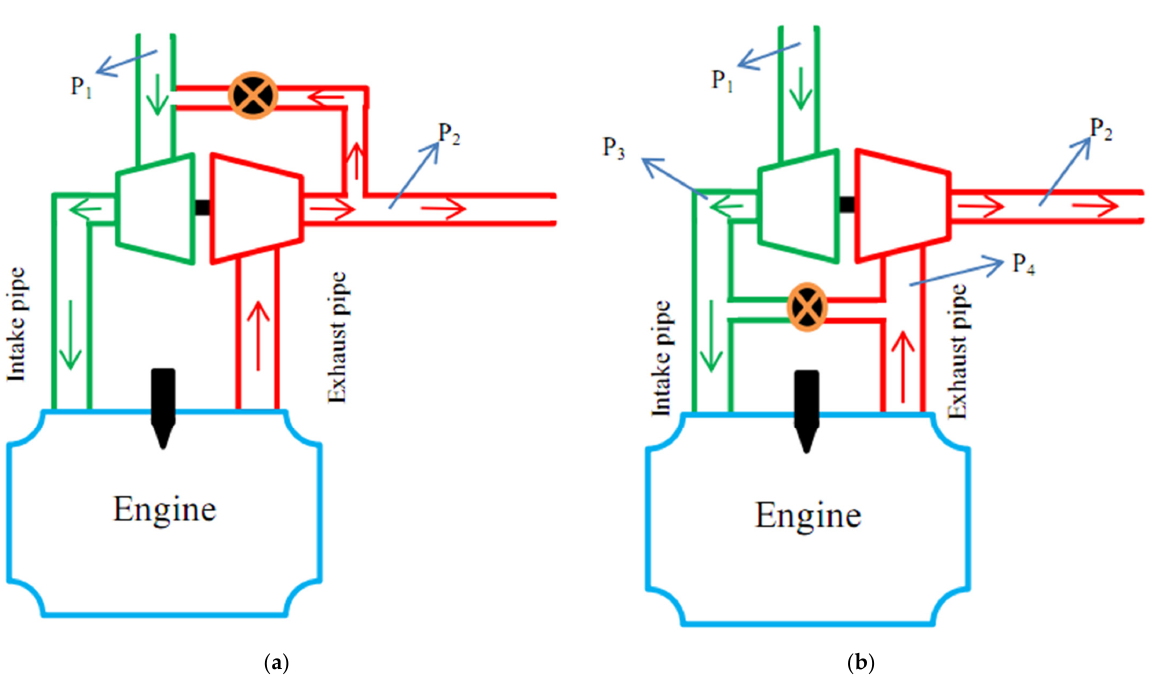
Figure 11. eEGR loop system: ( a ) Low ‐ pressure eEGR flow; ( b ) high ‐ pressure eEGR flow.